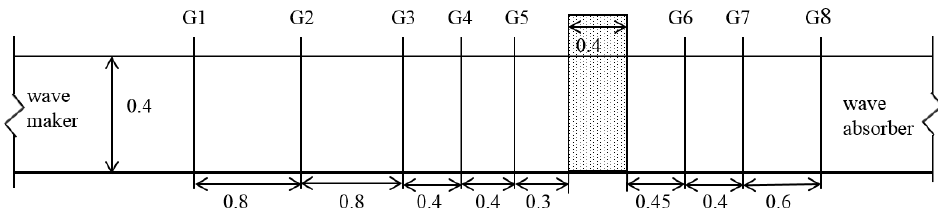
Figure 2. The sketch of experimental setup and wave gauge locations. (All dimensions in meters). Table 1. Test cases in flume experiments. Case